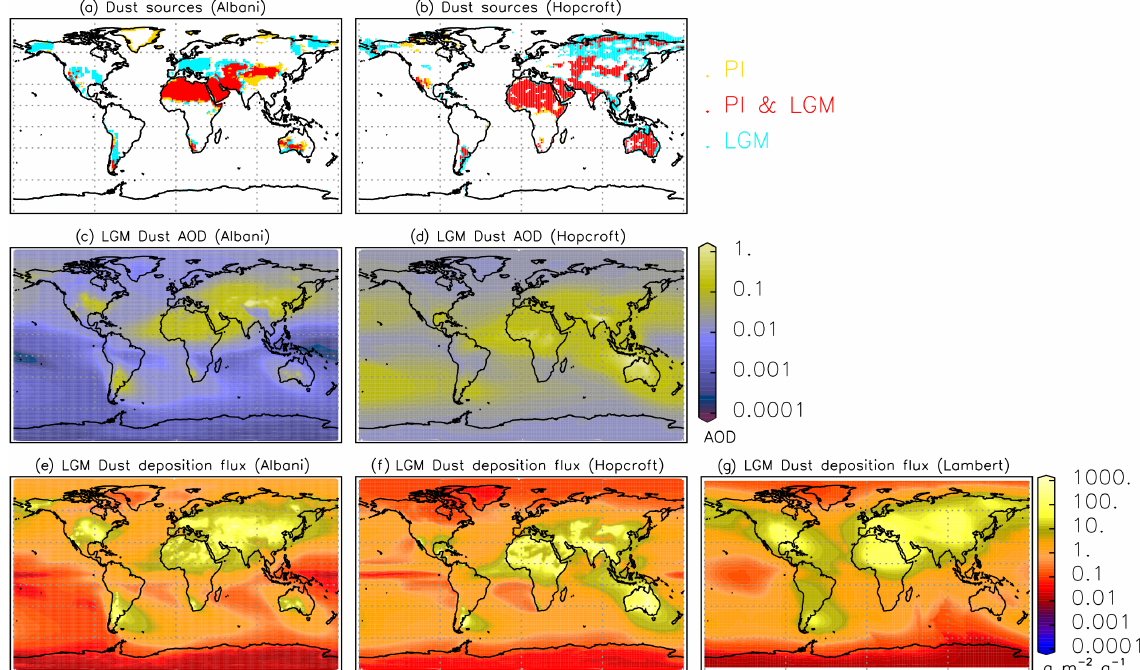
Figure 6. Maps of active sources for dust emissions in the LGM and pre-industrial (PI) conditions in the simulations: (a) with the Community Earth System Model (Albani et al., 2014) and (b) with the Hadley Centre Global Environment Model 2-Atmosphere (Hopcroft et al., 2015). Maps of LGM dust aerosol optical depth (AOD) from the simulations of (c) Albani et al. (2014) and (d) Hopcroft et al. (2015). Maps of LGM dust deposition (gm − 2 a − 1 ) (e) simulated with the Community Earth System Model (Albani et al., 2014), (f) simulated with the Hadley Centre Global Environment Model 2-Atmosphere (Hopcroft et al., 2015), and (g) reconstructed from a global interpolation of paleodust data (Lambert et al.,